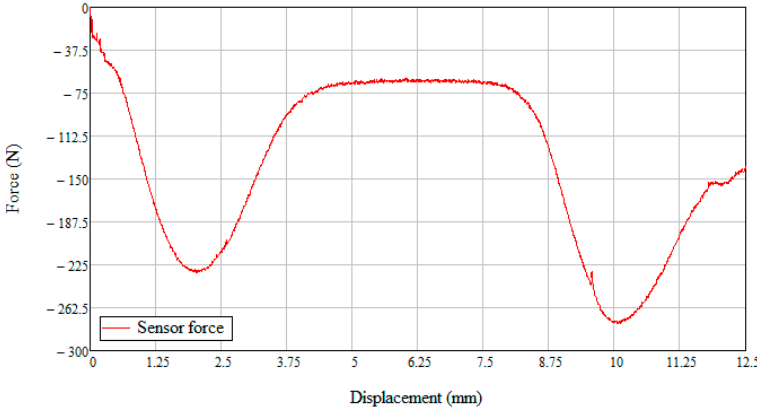
Figure 11. Axial force measured by the force sensor as a function of the displacement of the lid for the lubricated mounting.